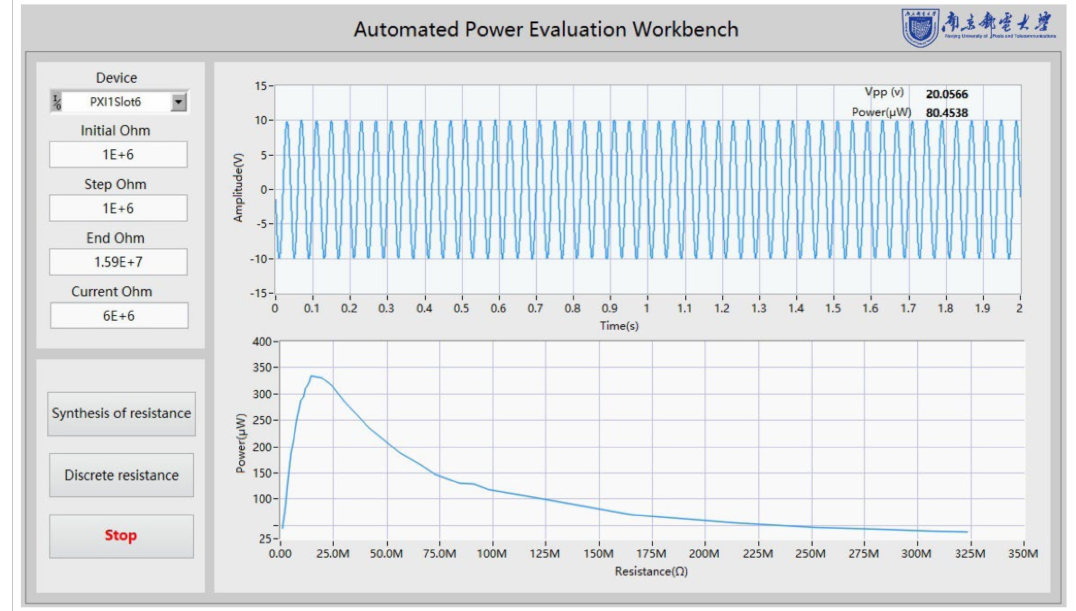
Figure 7. The APEW control panel.